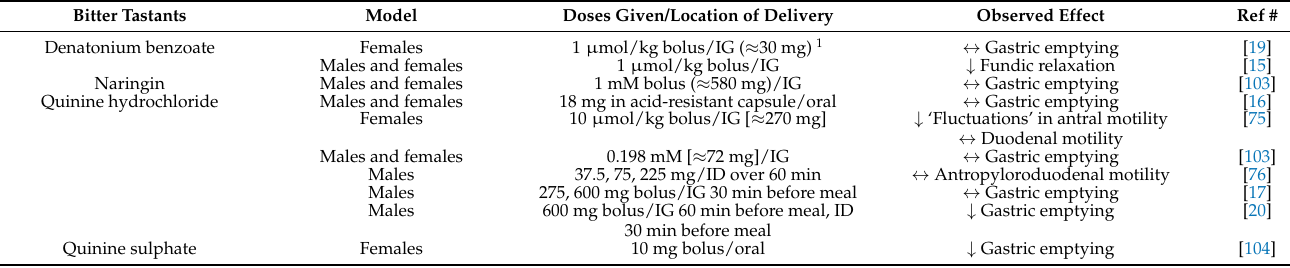
Table 4. Effects of bitter substances on gastric emptying and gastroduodenal motor function in healthy humans. Bitter Tastants